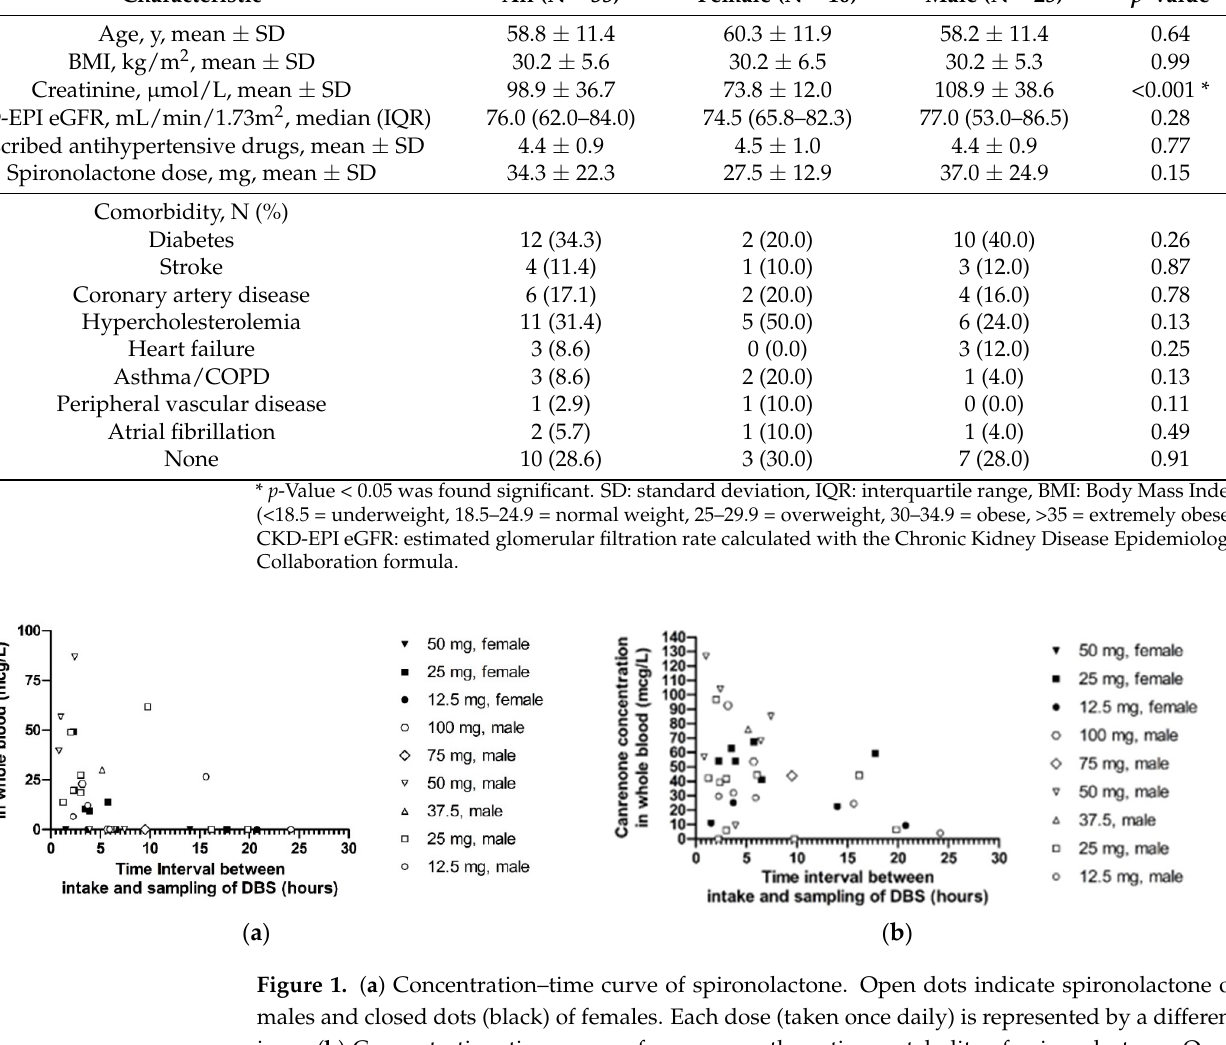
Table 3. Linear regression analysis on the influence of covariates on spironolactone and canrenone concentrations.